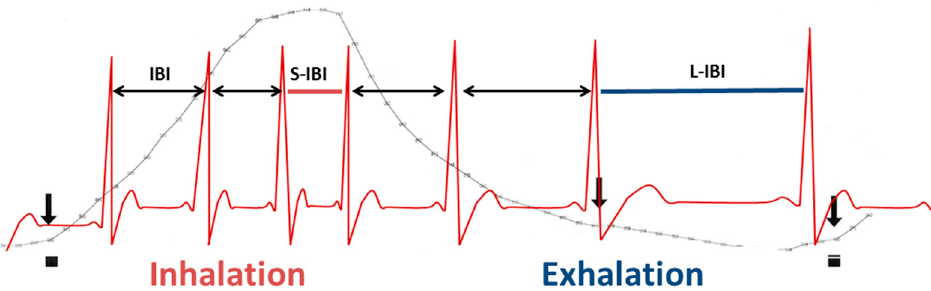
Figure 2. Respiratory sinus arrhythmia. Electrocardiogram in red, respiration in grey. IBI (black double headed arrows); inter-beat interval; the time between two consecutive R-peaks in the ECG. RSA; respiratory sinus arrhythmia; calculated as longest heart period during exhalation (L-IBI) minus the shortest heart period during inhalation (S-IBI).